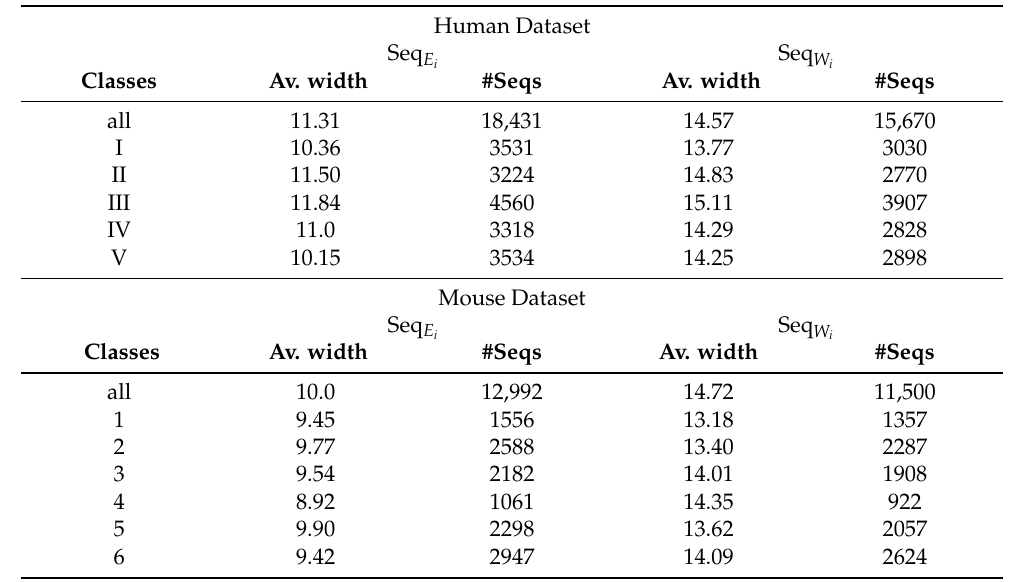
Table 3. Average width (column “Av. width”) of the best motif of width between 6 and 23 found by M EME using the oops site distribution on the sequences given by CLASH. The column “#Seqs” corresponds to the total number of sequences for each